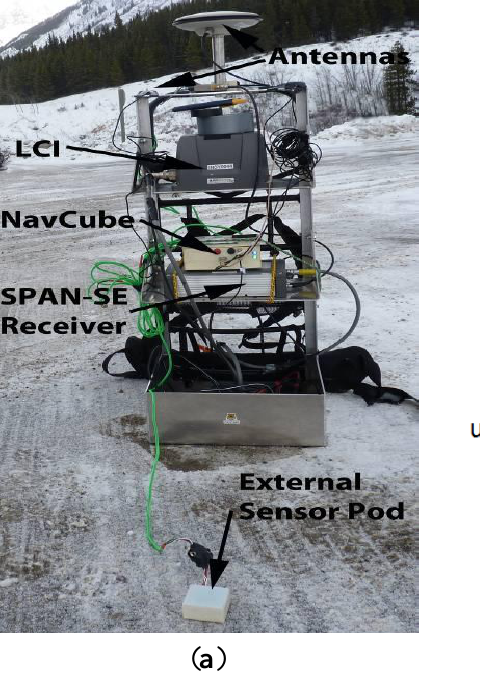
Figure 4. ( a ) Data collection equipment setup. ( b ) Block diagram of equipment